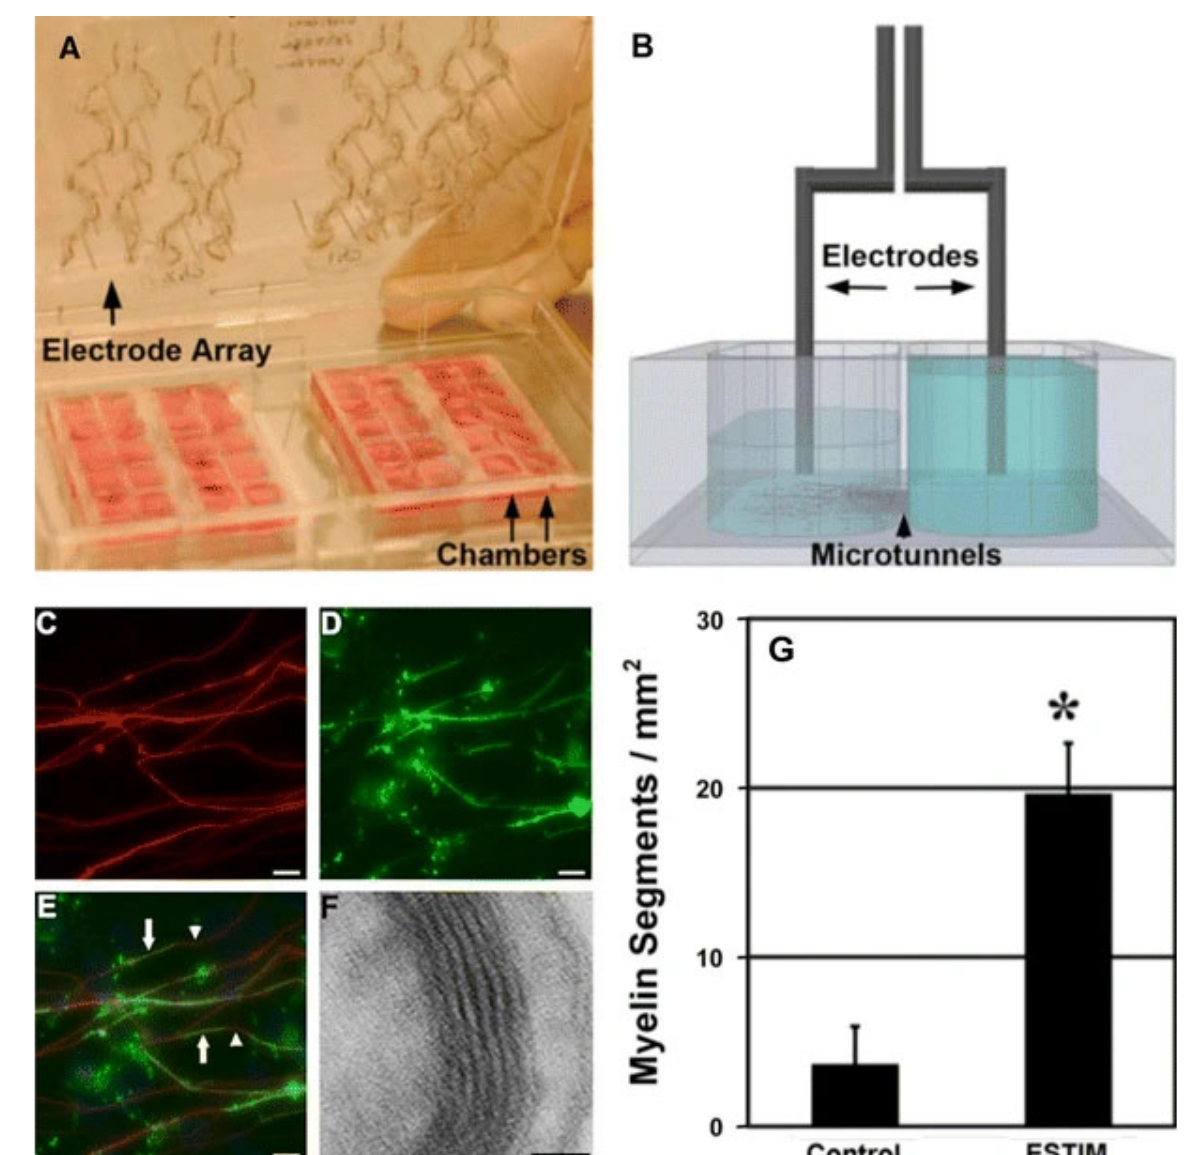
Figure 2. Compartmentalized microfluidic device consisting of two chambers connected with parallel channels. The chambers are inserted into a tray fitted with a lid containing 4 arrays of 5 electrode pairs used for stimulating both chambers at the same time ( A ), scheme showing a connection of electrodes in a chamber ( B ), myelination study; MBP-positive oligodendrocyte processes (green) contact with neurofilament-positive DRG processes (red) in the distal compartment of the microfluidic platform after 5 days of co-culture and stimulation. Arrows indicate MBP-positive myelin formation and arrowheads indicate non-myelinated axons. Scale bars = 15 µ m ( C – E ), TEM image of myelin formation, 6 to 10 wraps were formed. Scale bar = 20 nm ( F ) and comparison of myelin segment formation between control groups and electrical stimulated groups. Fivefold more myelin segments were observed in the group receiving electrical stimulation than control group (Asterisk indicates a p < 0.005). ( G ) (permission taken